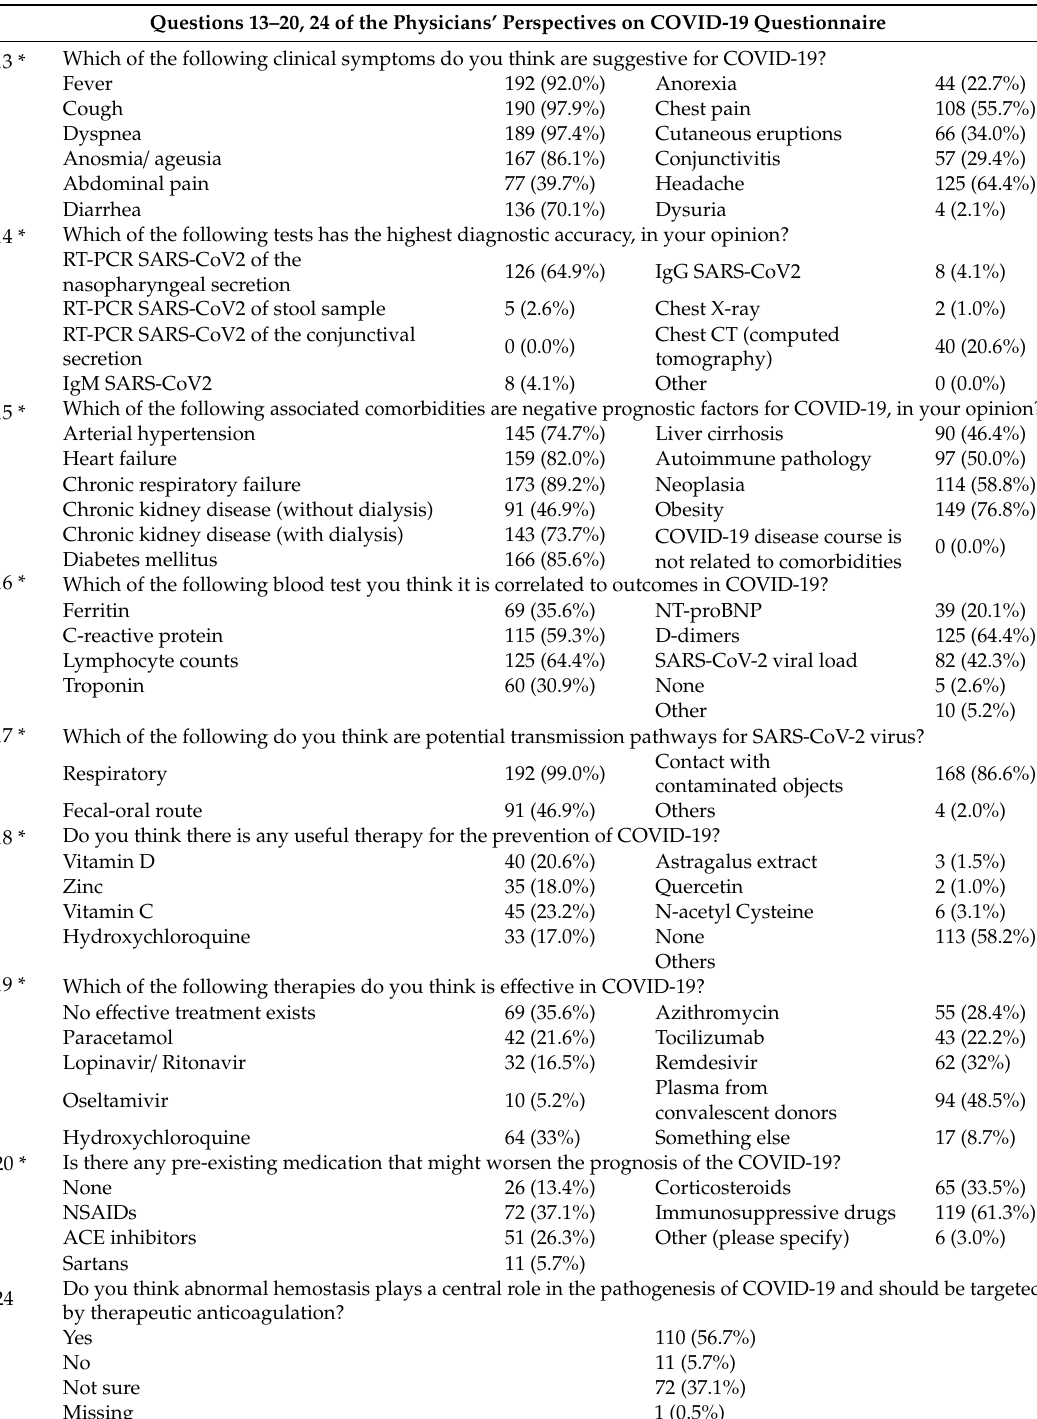
Table 3. Clinical and management selected